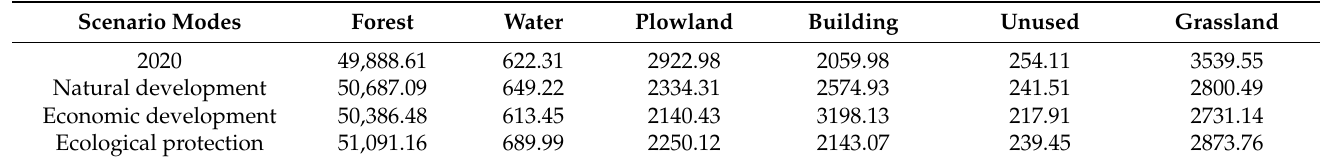
Table 4. Scenario simulated land use areas in 2020 and 2035 (km 2